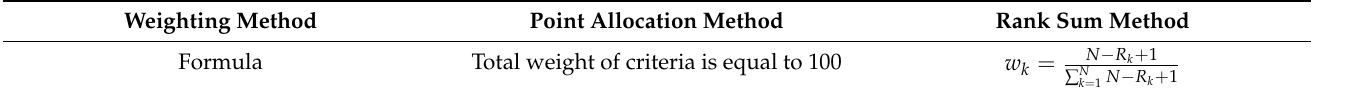
Table 8. Weighting methods to be used in the model, where k —consecutive number of criteria, w k — weight of the k -th criterion, N —total number of criteria, R k —rank of the k -th criterion.